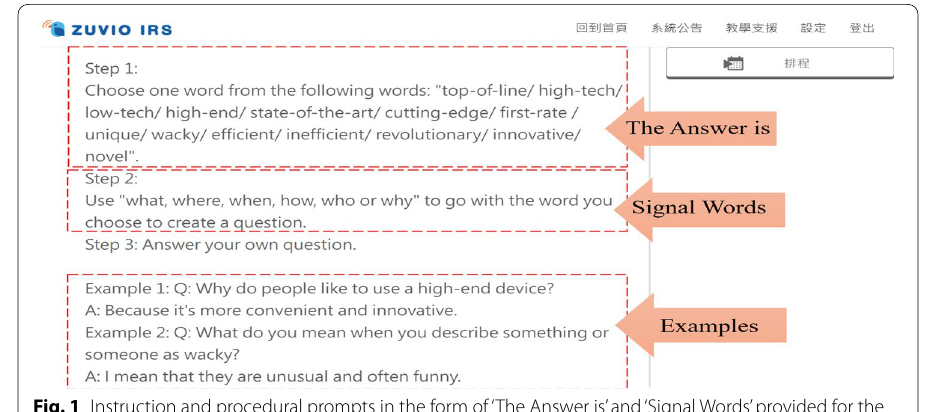
Fig. 1 Instruction and procedural prompts in the form of ‘The Answer is’ and ‘Signal Words’ provided for the